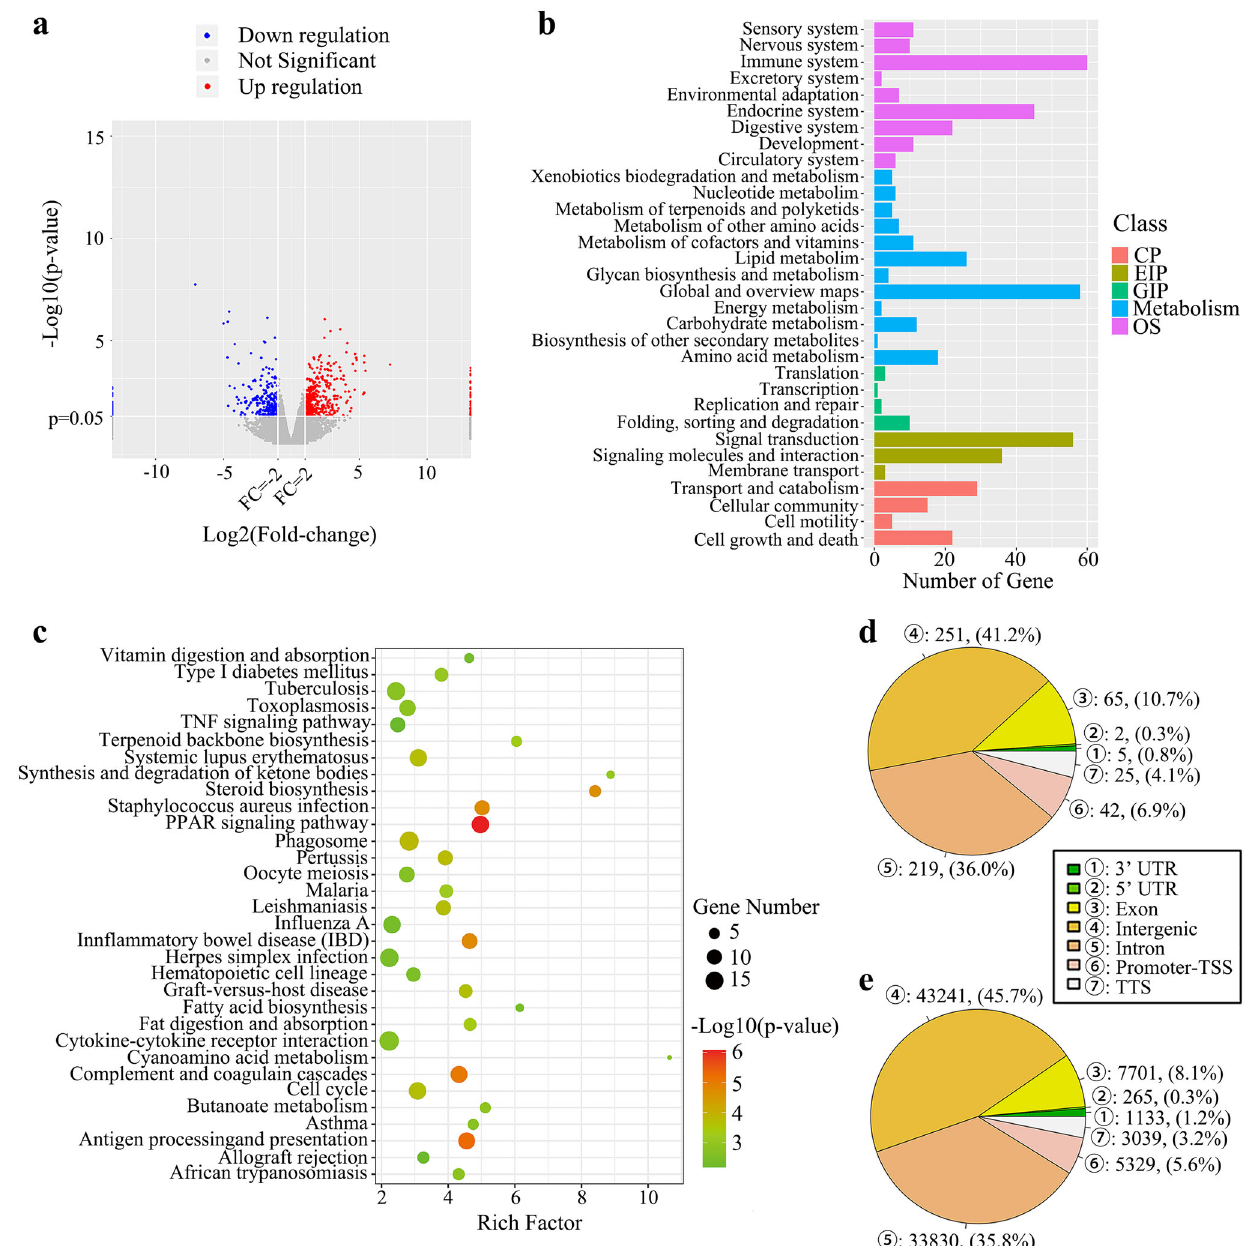
Fig. 5 Transcriptomics and methylomics information between the Model and Lyc group. a Volcano plot of differentially expressed genes (DEGs) between groups. b The top 30 KEGG classes which DEGs were classi fi ed. Noted that, CP: Cellular Processes, EIP: Environmental Information Processing, GIP: Genetic Information Processing, OS: Organismal Systems. c The KEGG pathways which DEGs signi fi cantly enriched. d Distribution of differentially methylated regions (DMR) and e differentially methylation sites (DMS) on different gene elements. Noted that, different colors and numbers in circle represented different gene